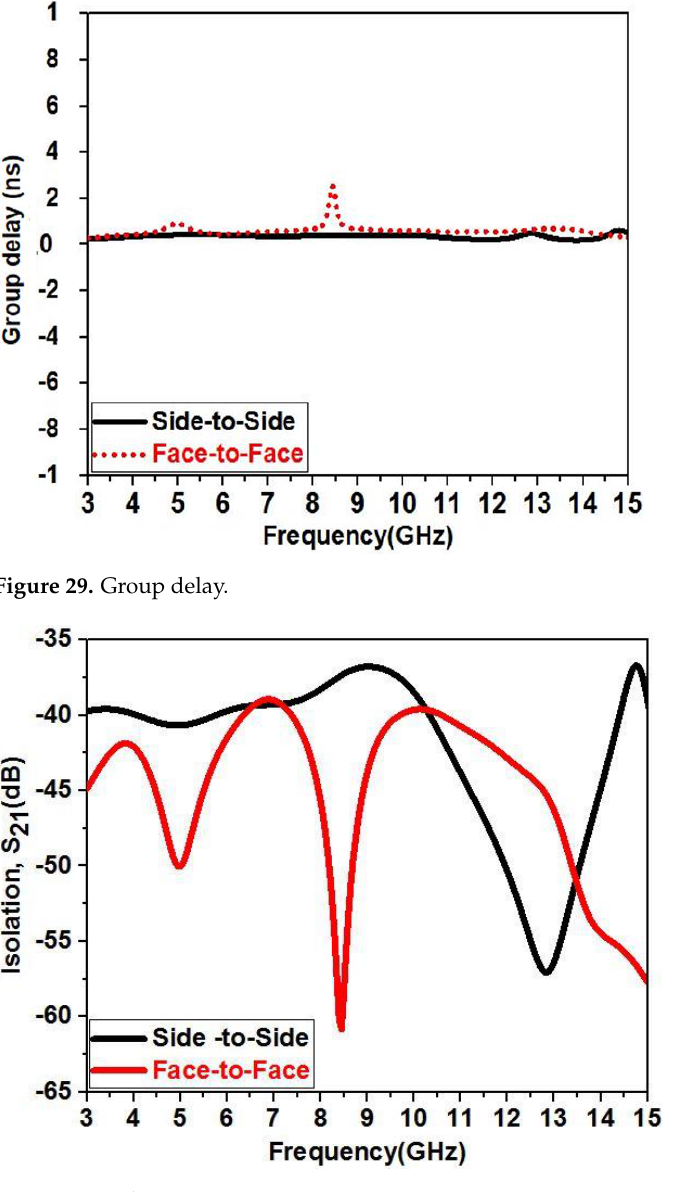
Figure 30. Isolation. Figure 30.